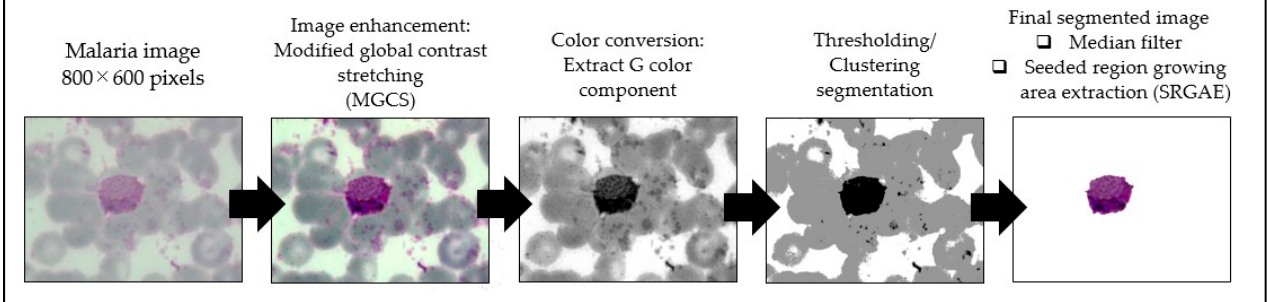
Figure 4. The framework of the proposed image-processing procedure for thin smear segmenta- tion.